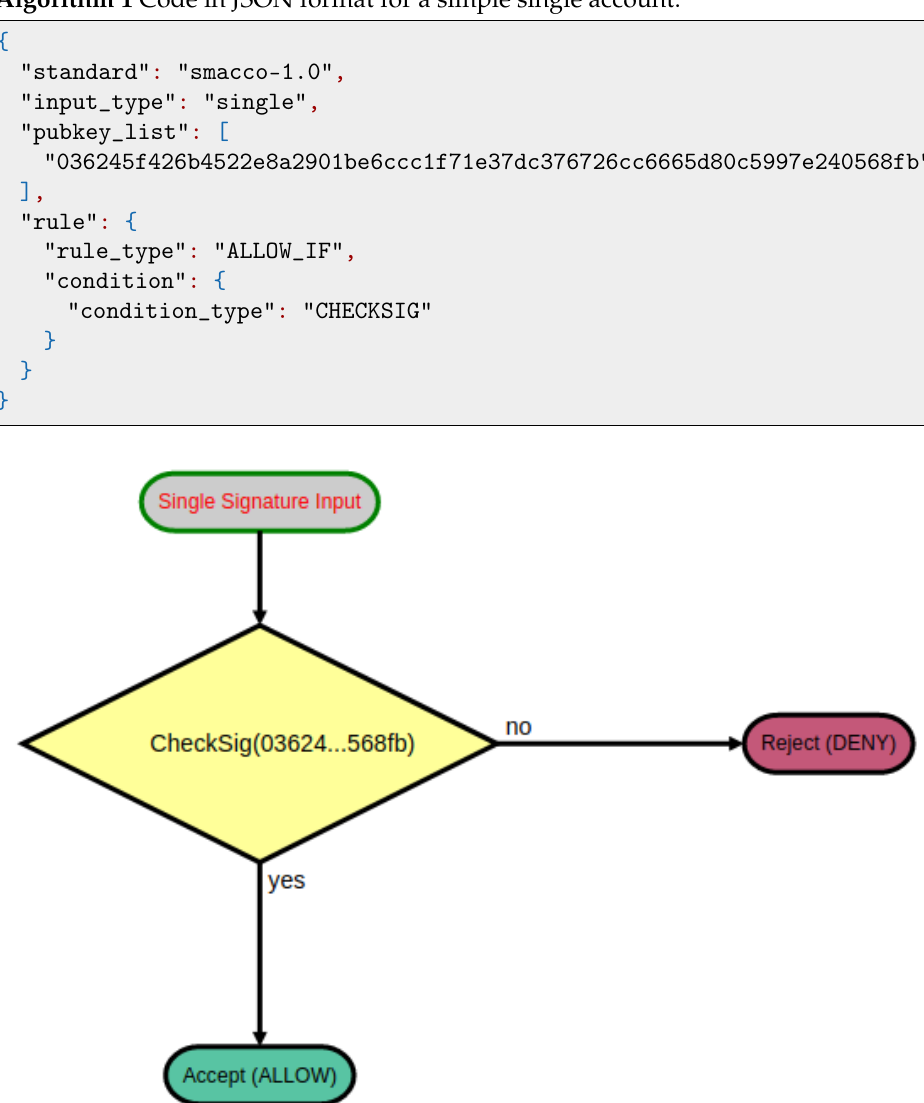
Algorithm 1 Code in JSON format for a simple single account.